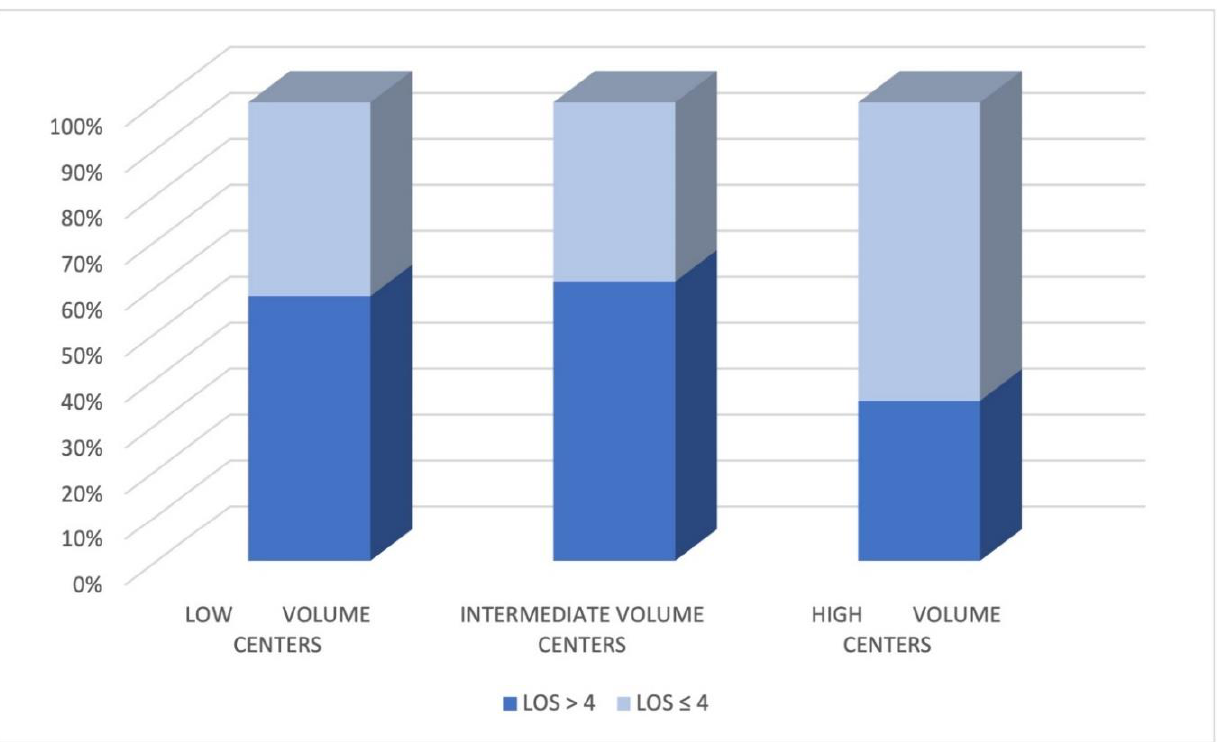
Figure 1. Correlations between length of hospital stay (LOS) and surgical centers’ activities volumes. Table 4. Patients’ intraoperative